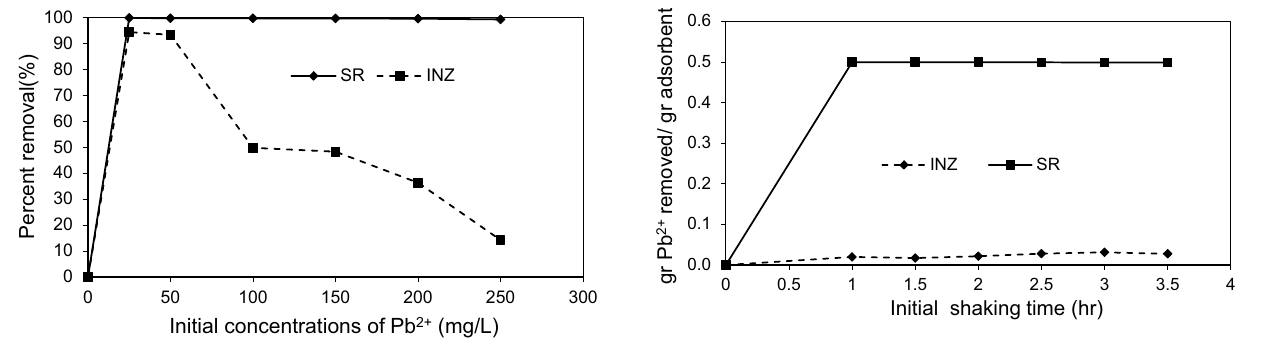
Fig. 3 Removal efficiency of Pb 2+ by INZ and SR in several solution concentrations (pH = 4.5, contact time = 120 min, adsorbent dose: INZ = 30 g/L, SR = 10 g/L)